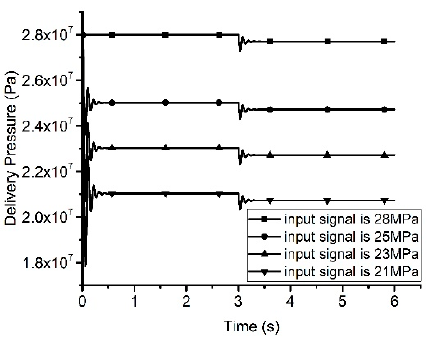
Figure 8. The delivery pressure of EHPAAPP with LQR method in the case of different input pressure signal with flow disturbance at the third second.